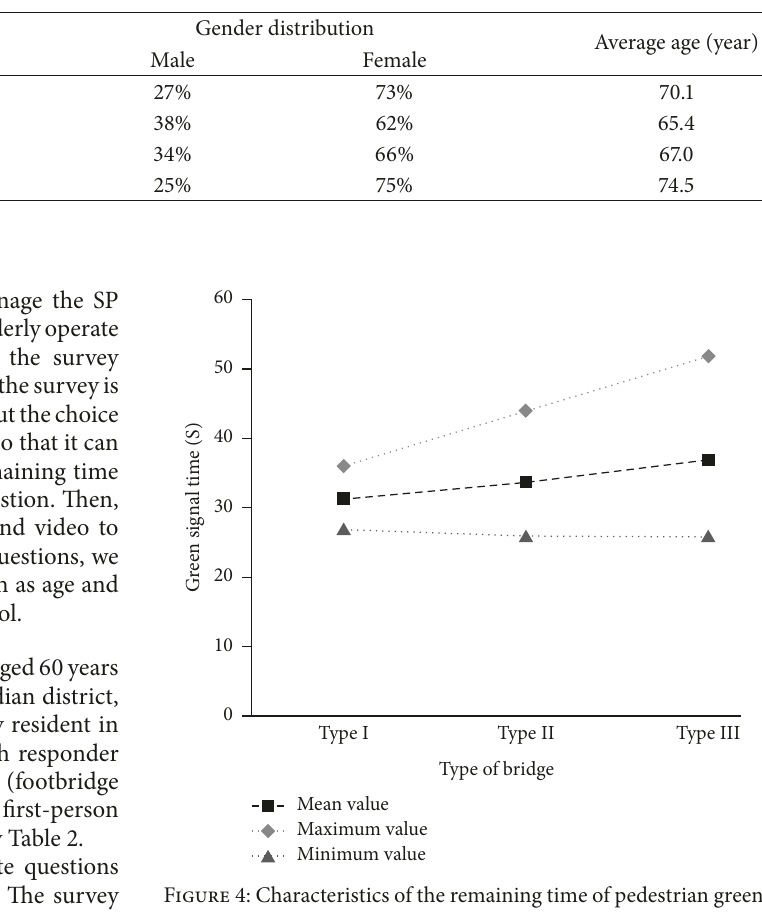
Table 2: Responders from four communities.